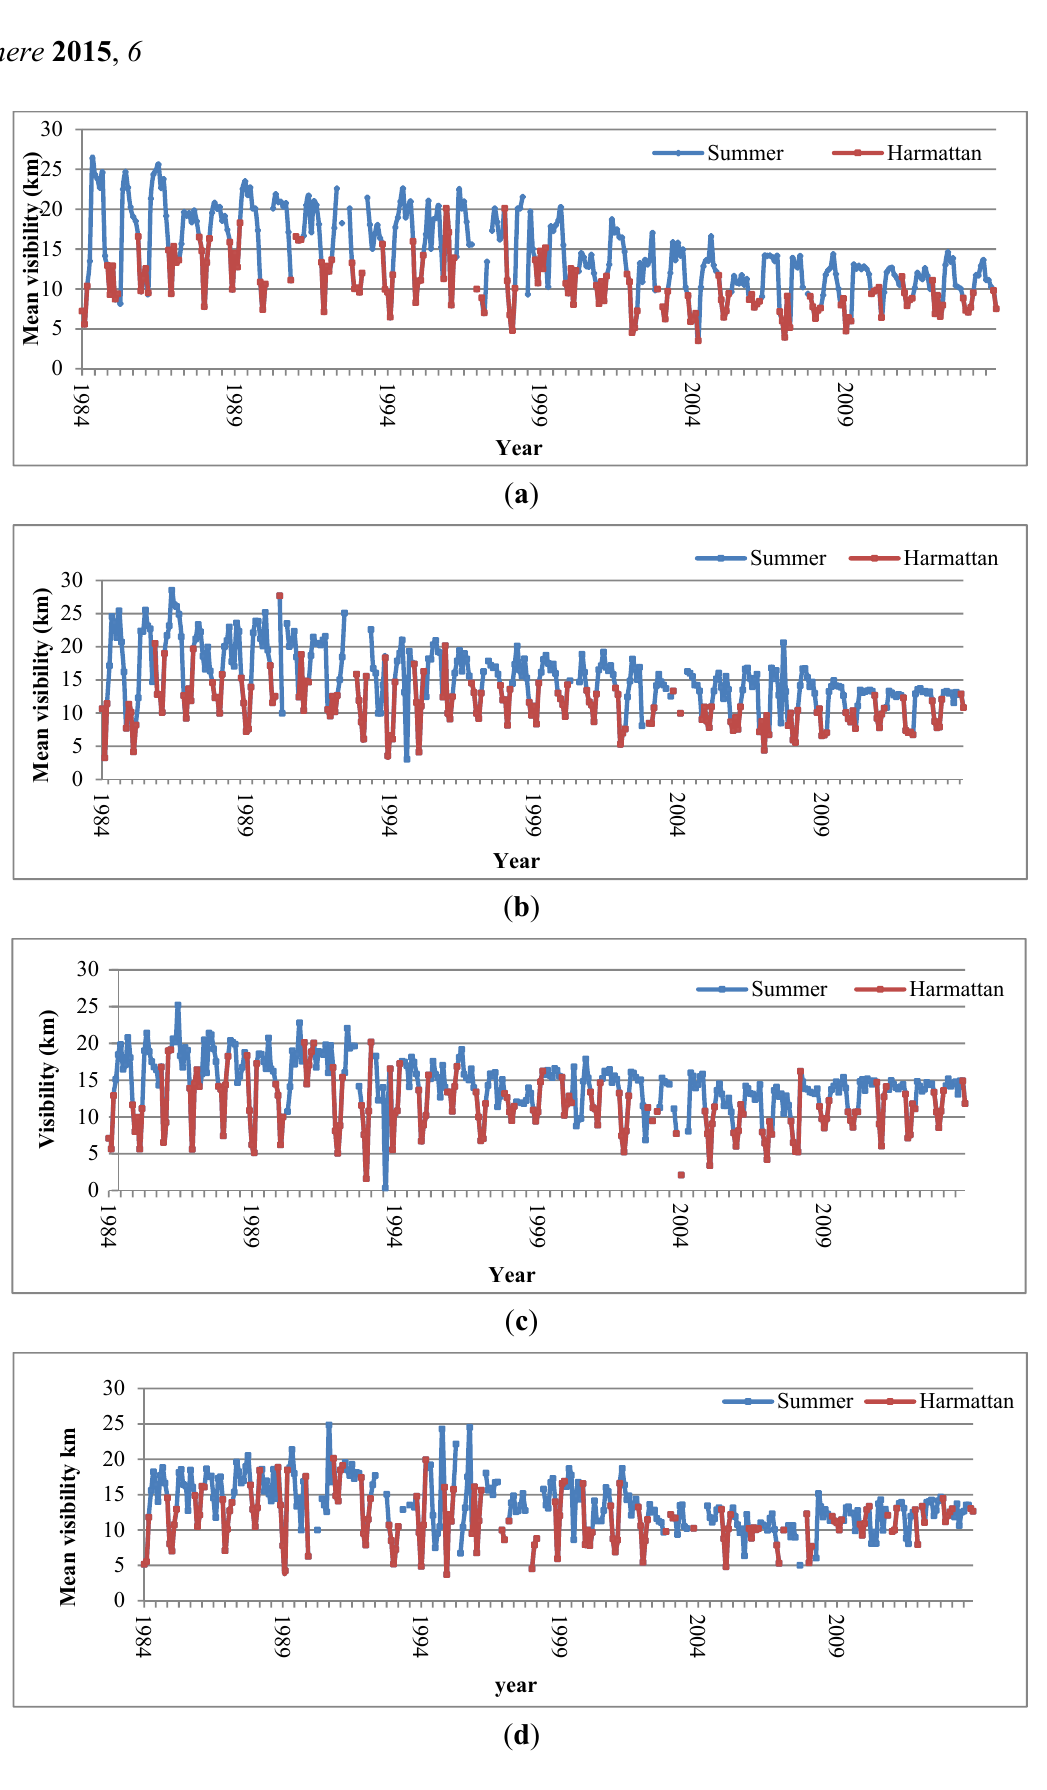
Figure 2. The monthly variation of day time visibility over 30-years period observed at four climatic zones of Nigeria. ( a ) sahel, ( b ) North central, ( c ) southern, ( d ) coastal